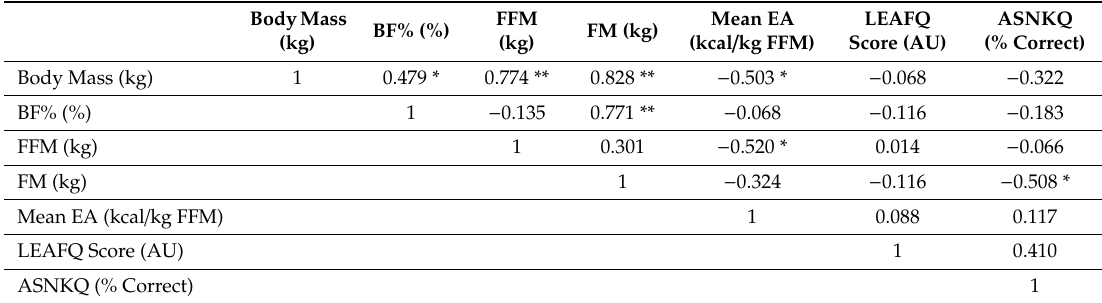
Relationships between body composition parameters, energy availability, and sport nutrition